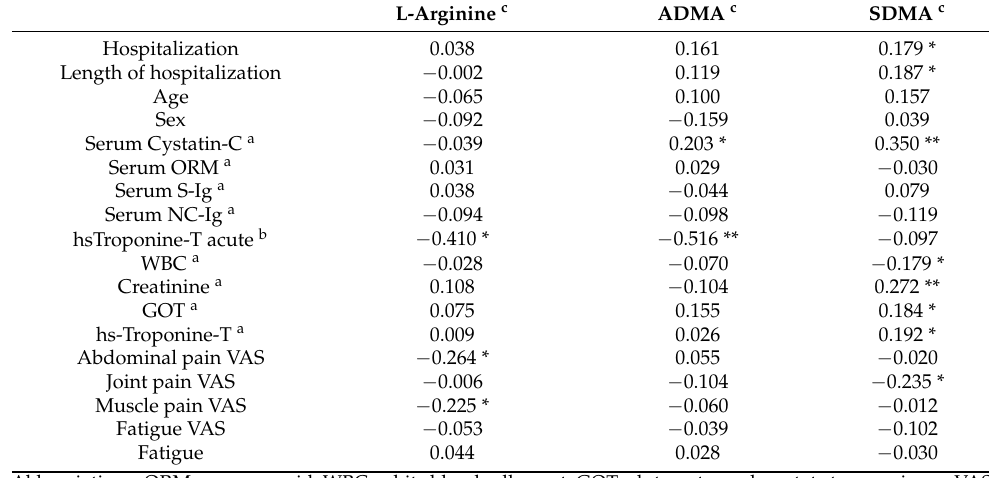
Table 3. Cross-sectional analysis among L-arginine, ADMA, and SDMA measured on baseline visit and clinical